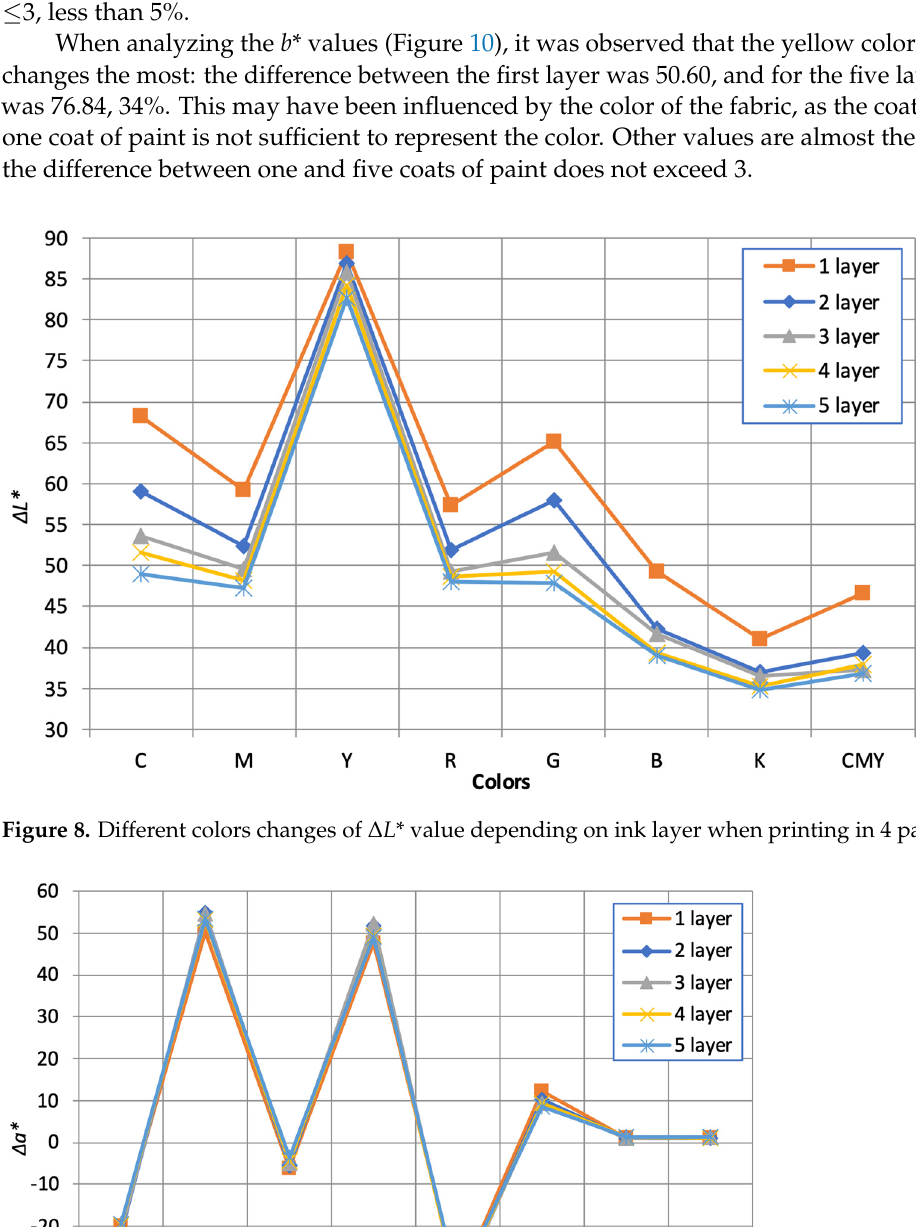
Figure 10. Different colors changes of Δ b * depending on ink layer when printing in 4 passes. In the study of the application of the two dye layers on bleached fabrics (Figure 11), it was observed that the thickest OBR 1542 fabric has the smallest change in Δ E color char- acteristics. It was also observed that the thinnest linen OBR 840 reproduces red, green, blue, black and brown. Additionally, when printing with two coatings, the color repro- duction is very good on OBR 0114, and the change in color characteristics is very similar to OBR 1542. The color characteristics Δ E values were found to be very similar for all bleached fabrics; the difference between them is not large ( ≤ 4). When studying the reproduction of color characteristics on melange fabrics (Figure 12) in the presence of two layers of paint, it was observed that the colors are best repro- duced on the thickest linen fabric OBR 482. Slightly worse colors are reproduced on the thinnest OBR 052 fabric. The color difference between different tissues is not large ( ≤ 4). The color yellow is reproduced practically equally on all fabrics. In the study of color reproduction on natural fabrics in the presence of two coats of paint (Figure 13), much larger changes in color characteristics were observed between dif- ferent fabrics. The largest difference was observed in yellow. It was also observed that the colors are much better reproduced on the OBR 051 fabric, slightly worse on the OBR 166